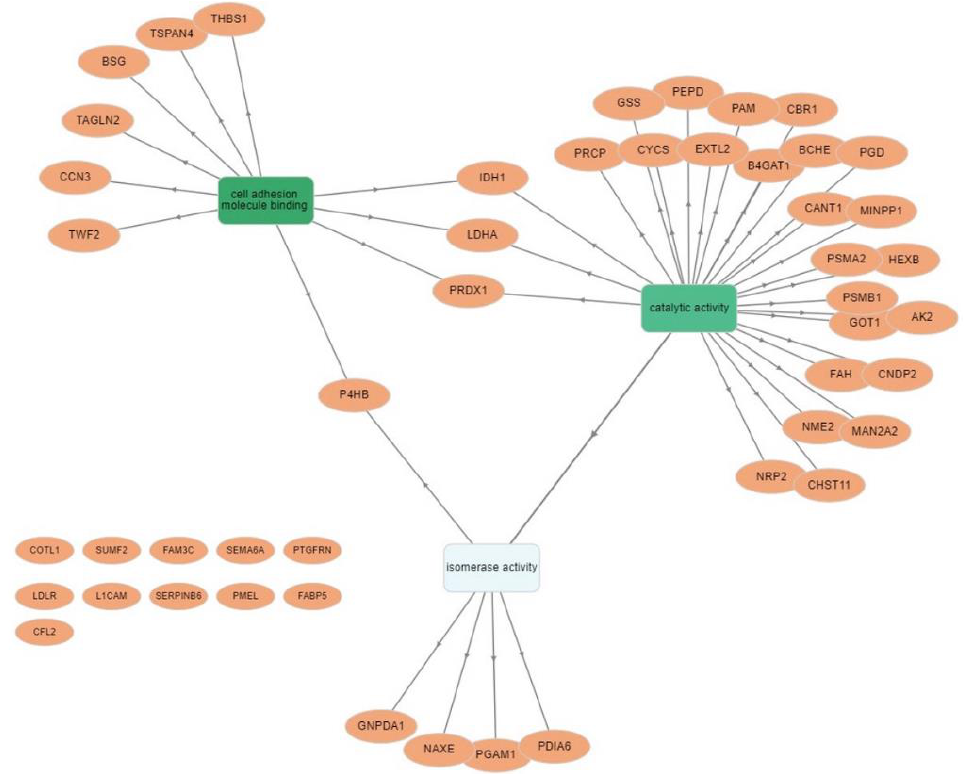
Figure 4. Gene ontology analysis of SK-MEL-28-VR2 cells using GOnet Internet application. Classification of specific proteins was performed according to molecular functions. Arrows indicate direct link between molecular functions according to the GOnet annotation. Round nodes represent proteins; square nodes represent various molecular functions. The darker color of the GOterm square node characterizes higher significance.